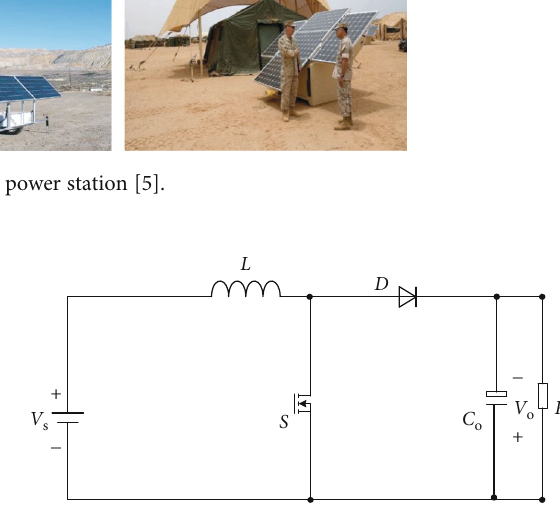
Figure 3: Conventional boost converter